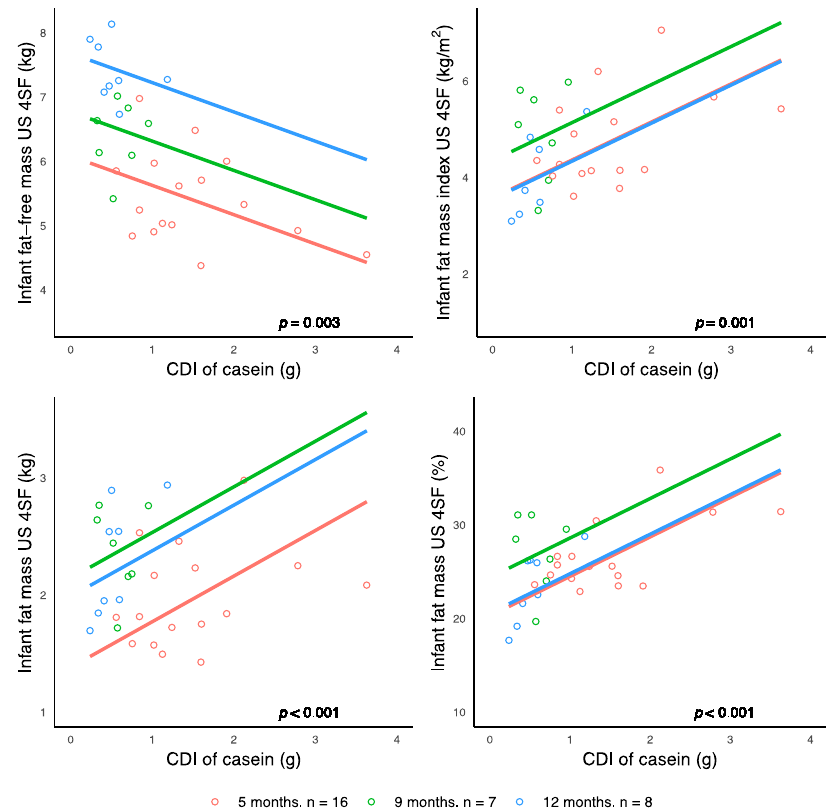
Figure 2. Significant associations between calculated daily intakes (CDI) of human milk casein and infant body composition parameters measured with ultrasound four-skinfolds. Lines represent linear regression and grouped by the month of lactation.